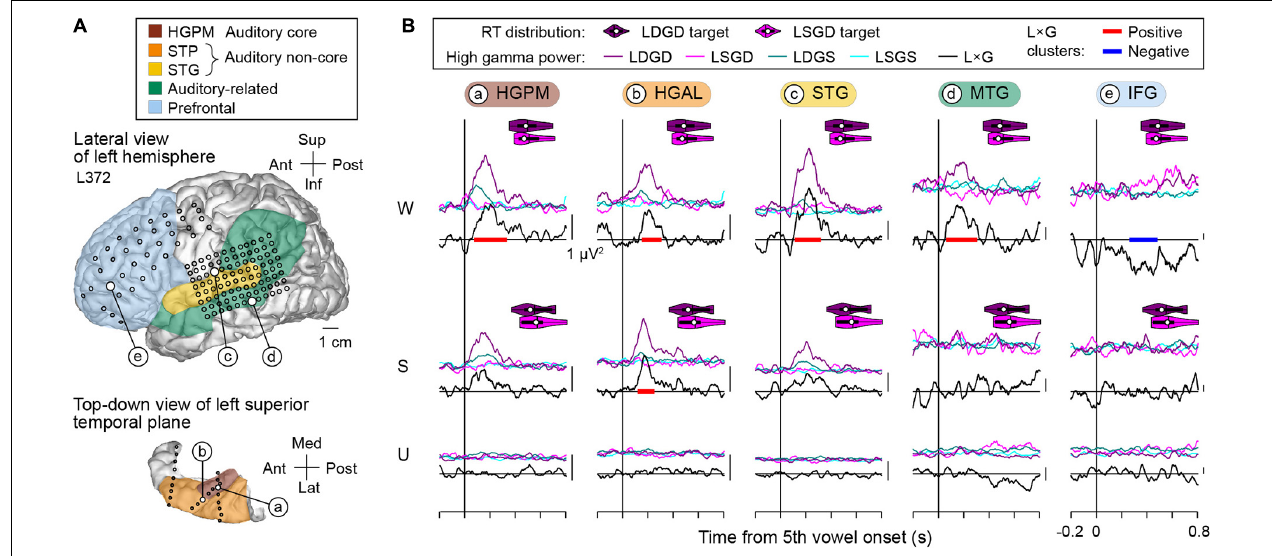
FIGURE 6 | L × G interactions during induction of general anesthesia in a representative subject with left hemisphere electrode coverage (L372). See caption of Figure 5 for detail.